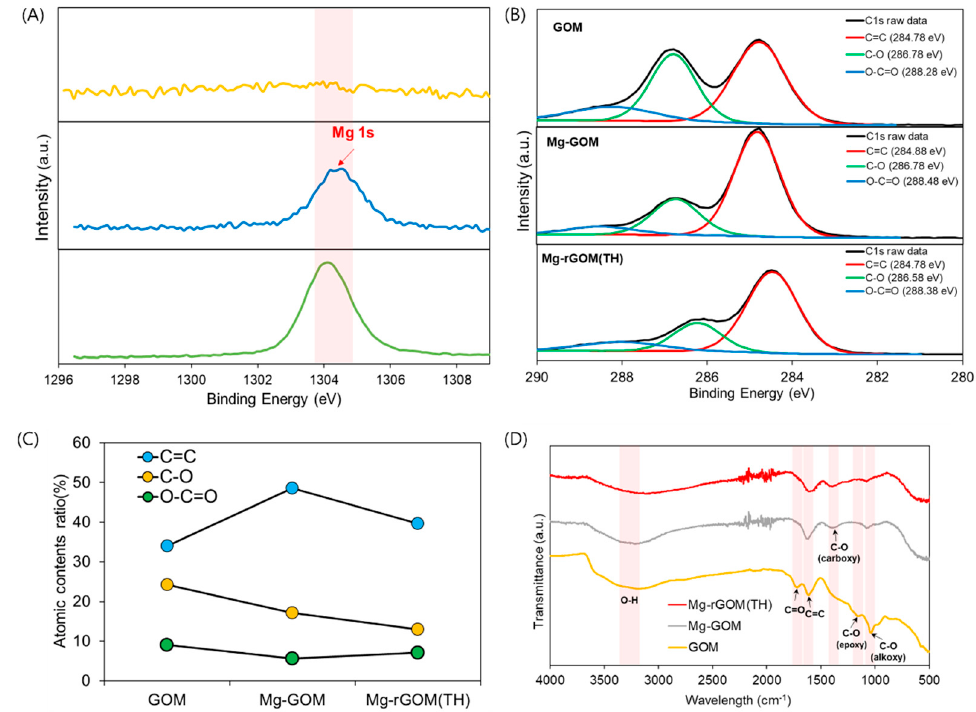
Figure 4. ( A ) The high-resolution XPS spectra for Mg 1 s , ( B ) the high-resolution deconvoluted XPS spectra for C 1 s , ( C ) the atomic content ratio of carbon-related bonds (C=C, C–O, and O–C=O), and ( D ) the FT-IR spectra of the GOM series.